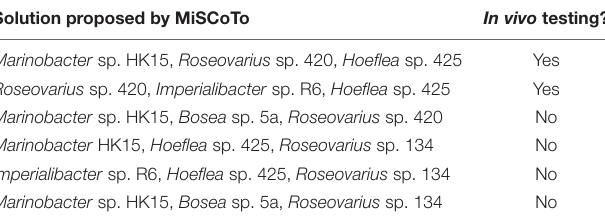
TABLE 3 | Minimal bacterial consortia predicted by MiSCoTo that enabled the production of 160 algal compounds. Solution proposed by MiSCoTo In vivo